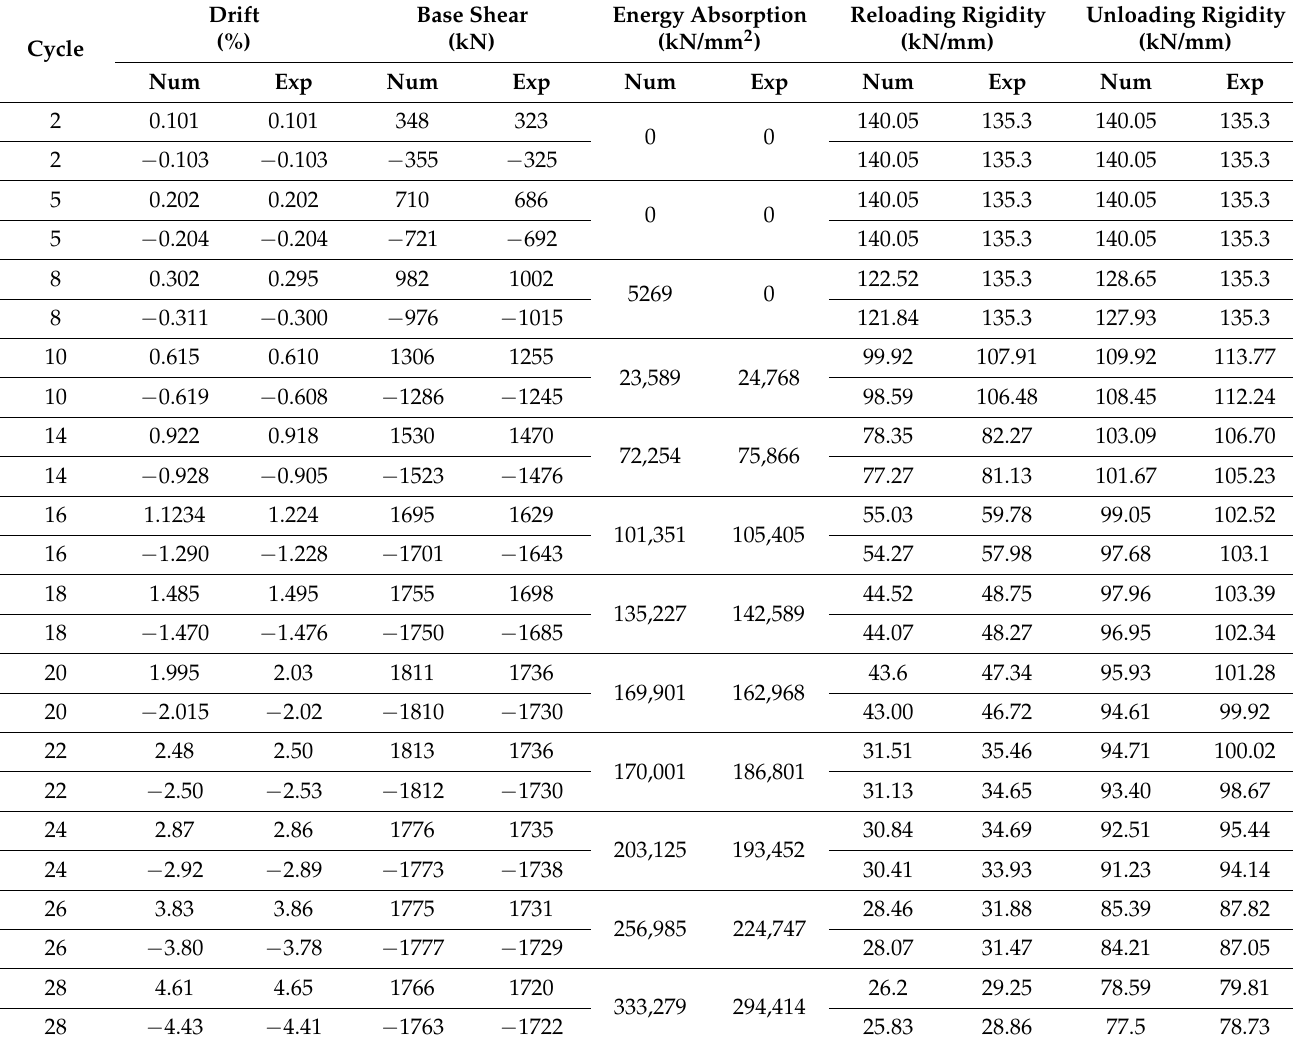
Table 4. Hysteresis comparison of the numerical and experimental